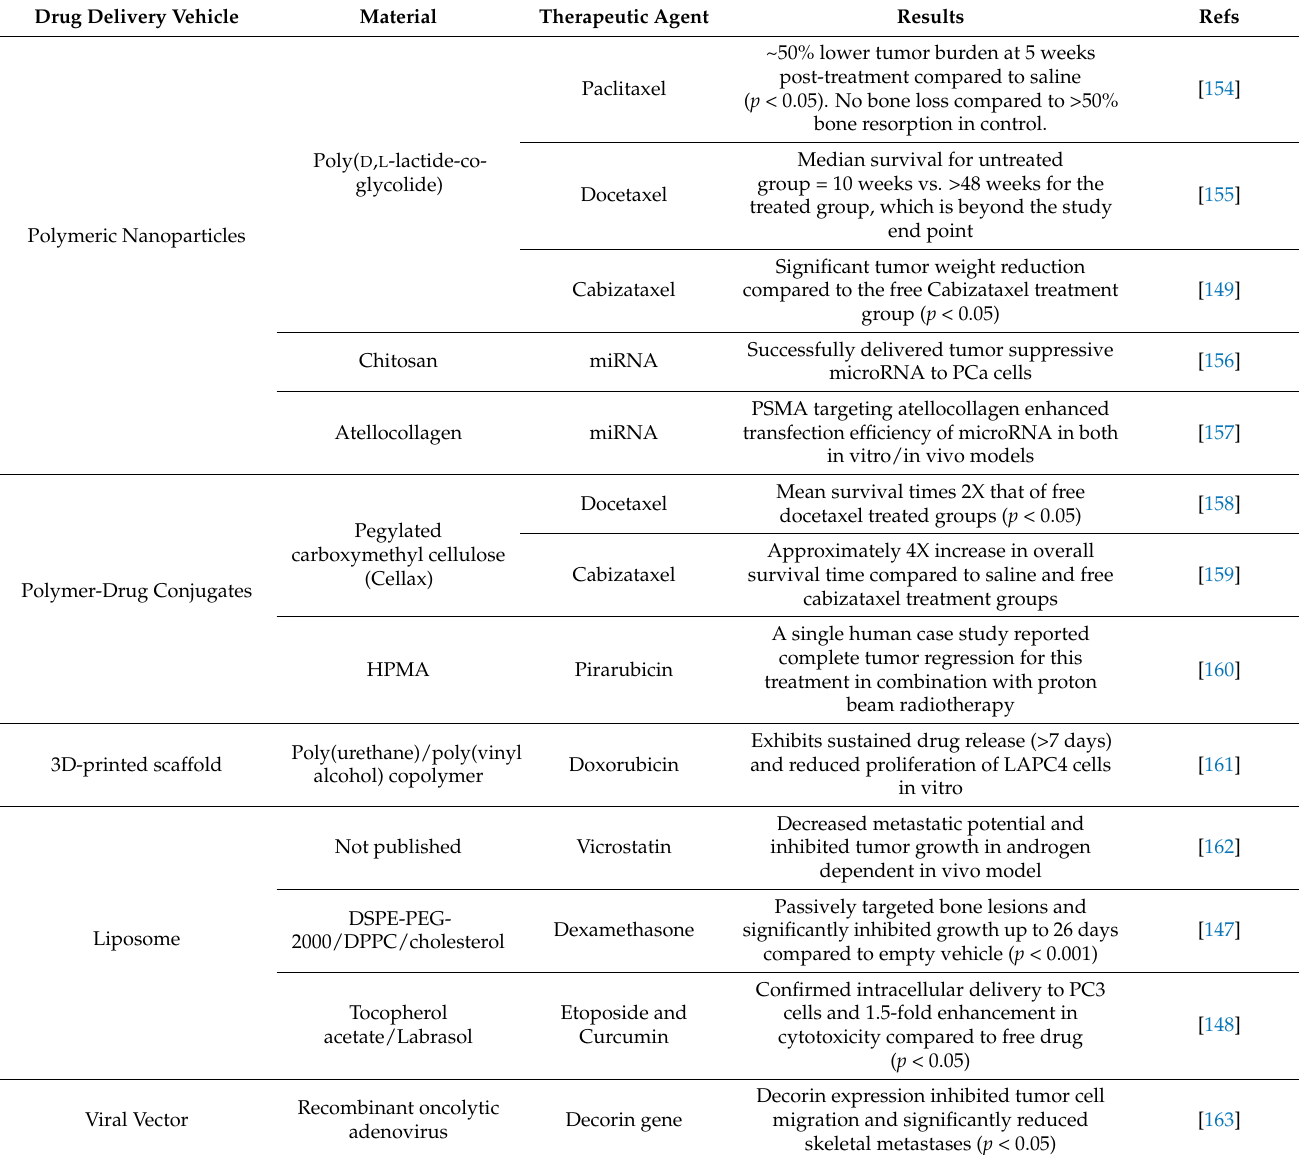
Table 2. Drug delivery platforms used for bone metastatic PCa